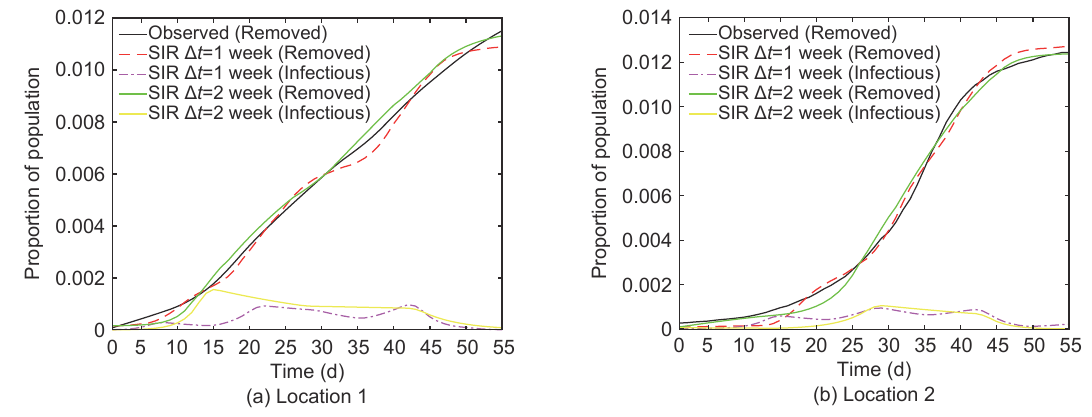
Fig. 3 Curve fitting for Location 1 and Location 2 using